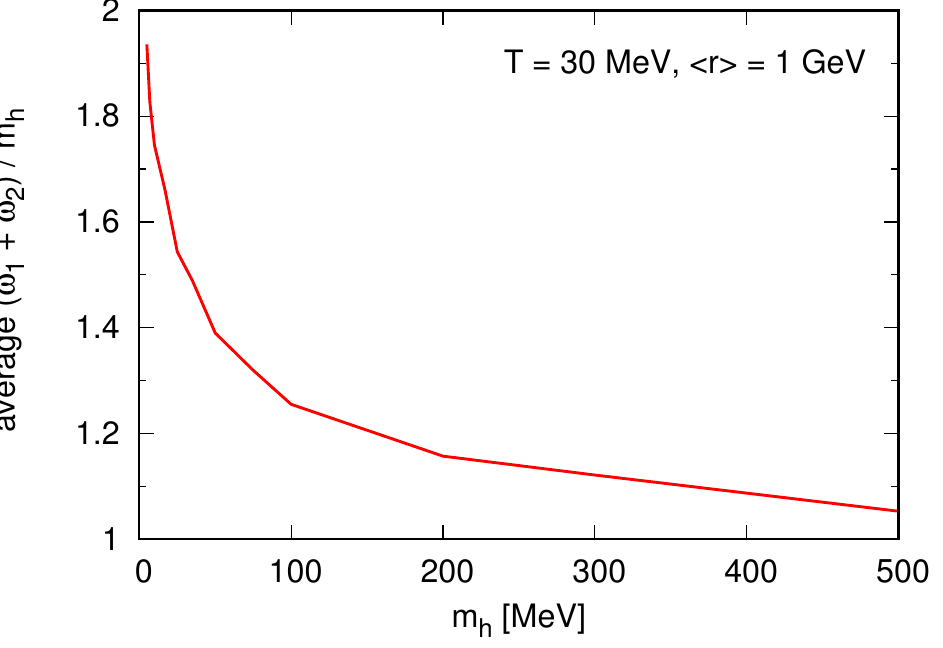
Figure 7 . Goldstone boson average emission energy ! = ! 1 + ! 2 in dependence of the light Higgs boson mass m h . Both the energy loss rate Q nn ! nn(cid:11)(cid:11) and the thermally averaged cross section h (cid:27) nn ! nn(cid:11)(cid:11) i v M are calculated in the non-degenerate (ND) limit, for proto-neutron star core temperature T = 30 MeV, neutron fraction X n = 1, and the radial (cid:12)eld vacuum expectation value h r i = 1